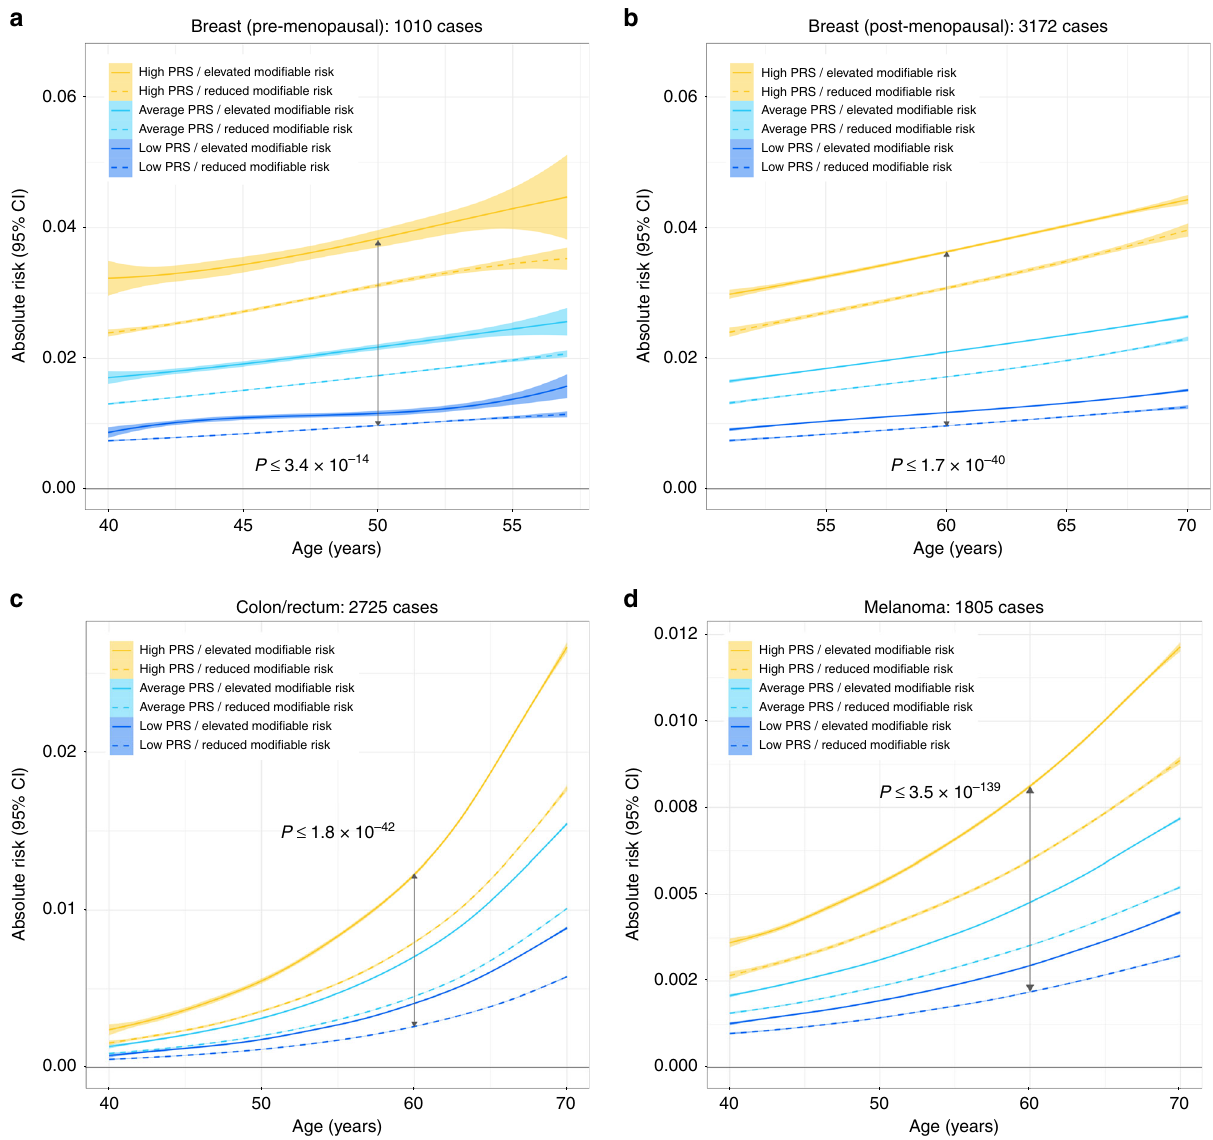
Fig. 4 Predicted 5-year absolute risk trajectories across strata de fi ned by modi fi able risk factors and percentiles of the polygenic risk score (PRS) distribution. Low PRS corresponds to ≤ 20th percentile, average PRS is de fi ned as >20th to <80th percentile, and high PRS includes individuals in the ≥ 80th percentile of the normalized genetic risk score distribution. Individuals below the median of the modi fi able risk factor distribution were classi fi ed as having reduced risk, whereas those above the median had elevated risk. P values for differences in mean absolute risk in each stratum at age 50 for a pre- menopausal breast cancer and at age 60 for b post-menopausal breast cancer, c colon/rectal cancer, and d melanoma are based on t -tests (two